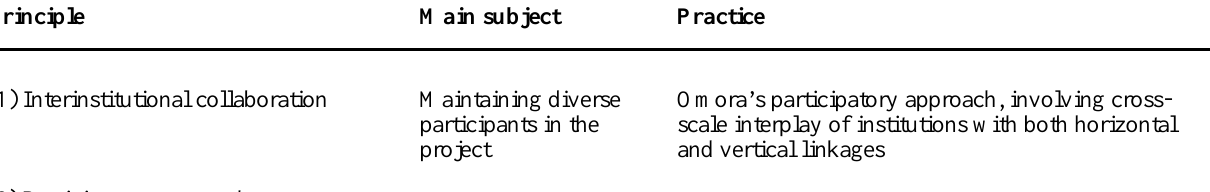
Table 1. Ten principles guide the actions of Omora Park to implement biocultural conservation at the southern extreme of the Americas. All principles interact simultaneously and have multiple functions; however, they can be grouped under three main subject areas and practices that enable Omora to put these concepts into